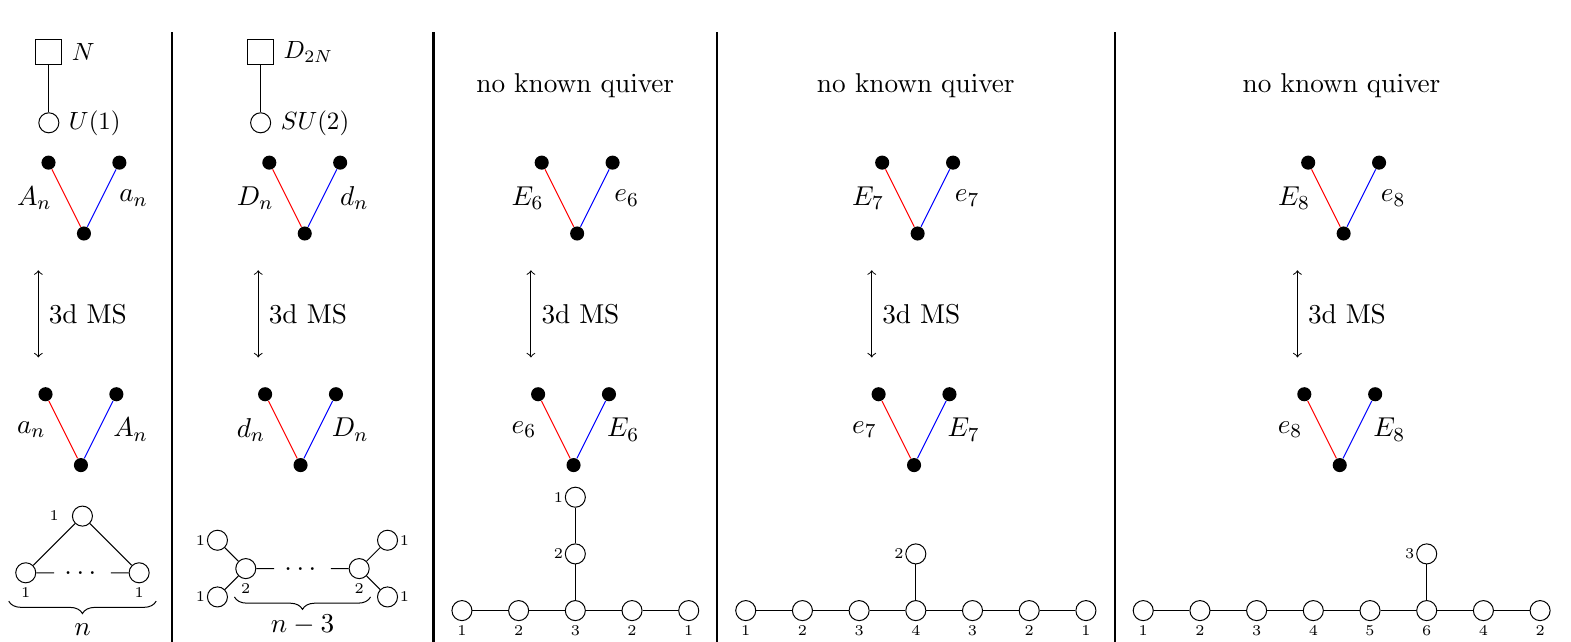
Table 2 . The full Hasse diagram of theories with ADE type Kleinian singularities or minimal nilpotent orbit closures as Coulomb / Higgs